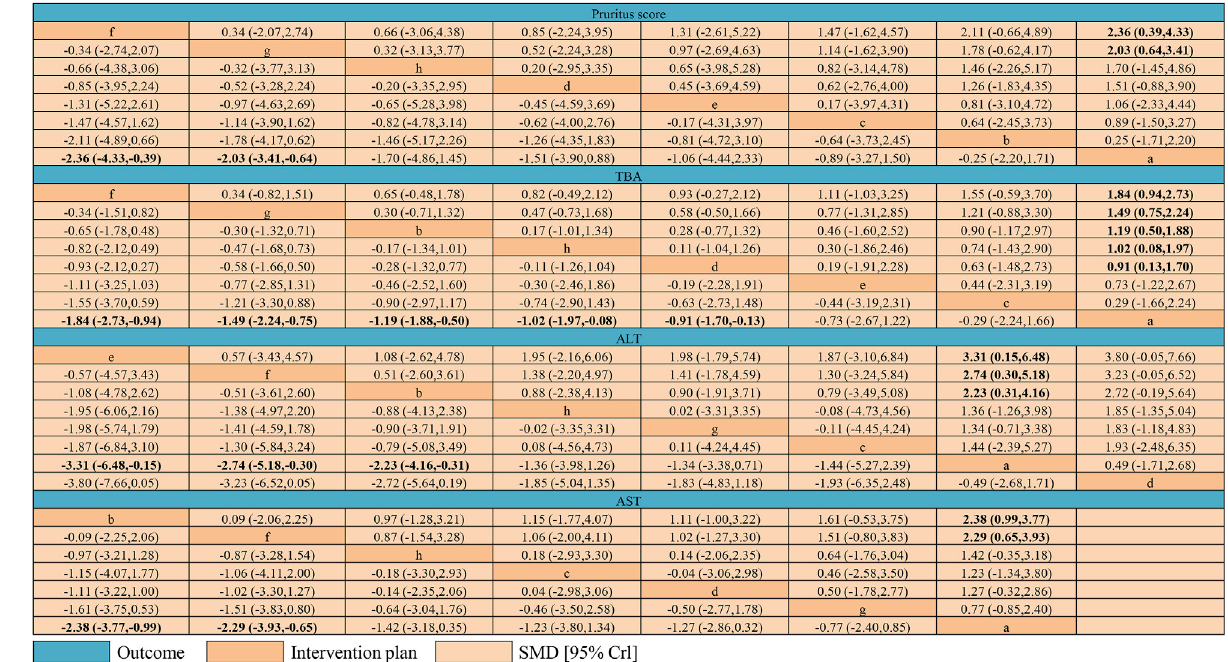
Frontiers in Pharmacology |